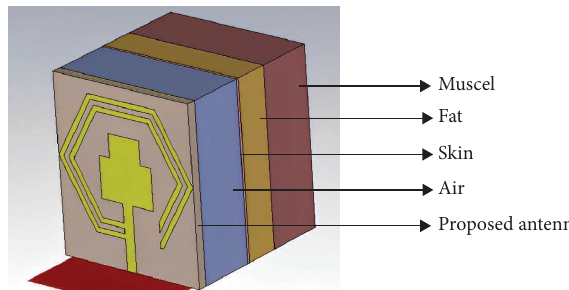
Figure 14: Proposed low-SAR penta-band microstrip patch an- tenna with human model.